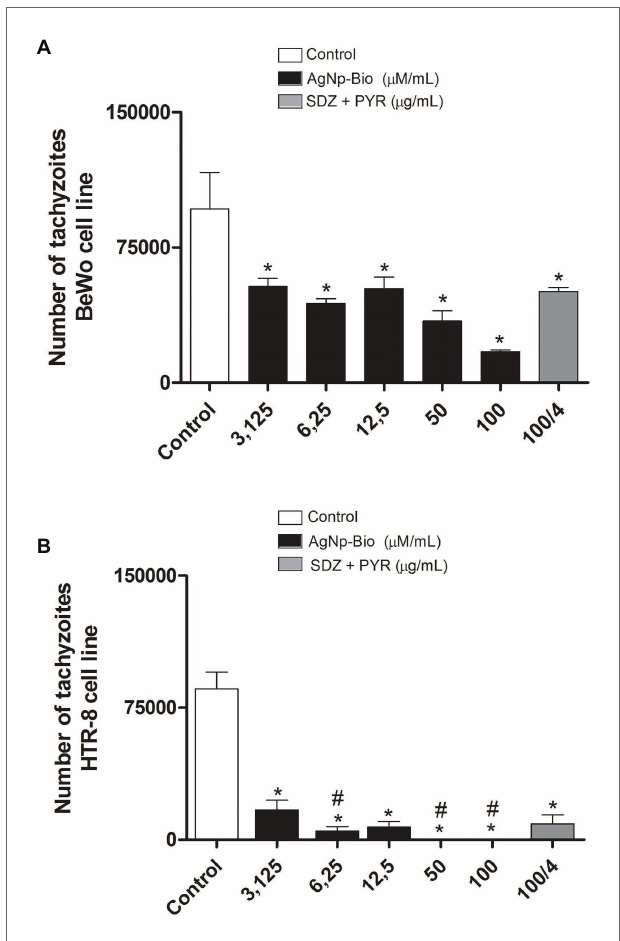
FIGURE 4 | Toxoplasma gondii proliferation (2F1 clone) in BeWo (A) and HTR8 (B) treated with different drugs. After culturing and infecting the cells with T. gondii (RH-2F1 clone) for 24 h, treatment with the nanoparticles and the combination of sulfadiazine/pyrimethamine (SDZ + PYR) was performed for later β -galactosidase colorimetric assay. Data were shown as mean ± SEM of T. gondii proliferation from three independents experiments in nine replicates. Significant differences in relation to BeWo, HTR8 cells infected and untreated (control; * p < 0.05; A,B ) and nanoparticles and SDZ + PYR ( ≠ p < 0.05; A,B ). Differences between groups were analyzed by One-Way ANOVA with the Bonferroni multiple comparison post hoc